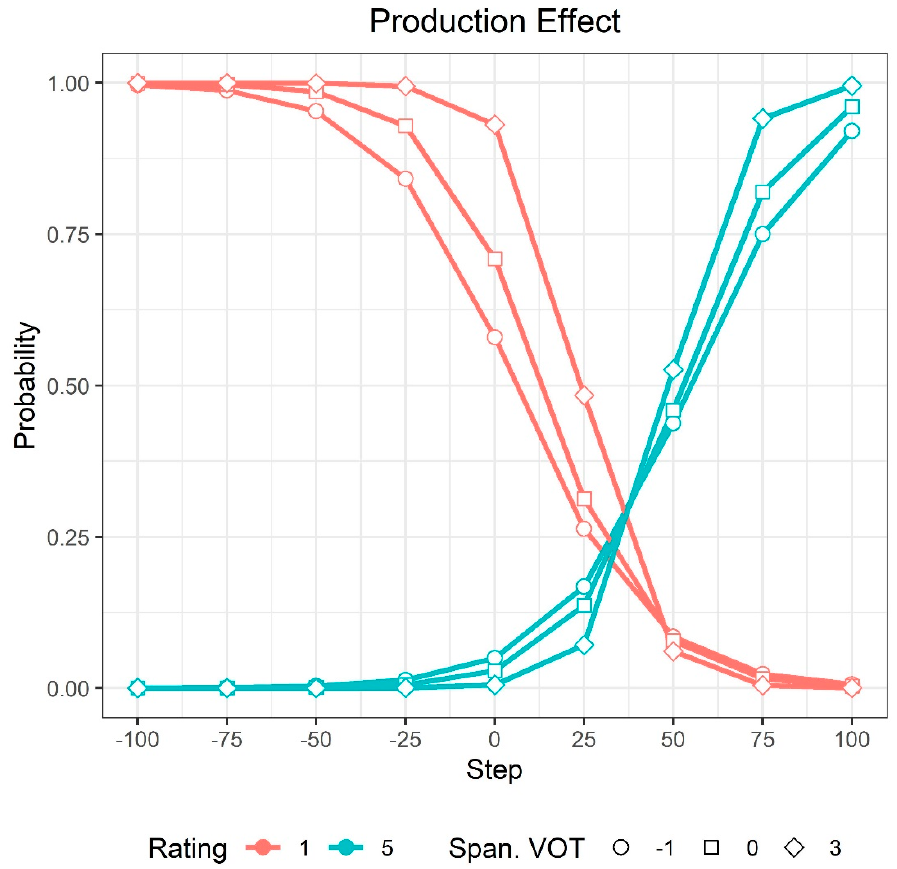
Figure 4. Predicted probabilities of response ratings for voiceless trials as a function of participants’ model-estimated VOT production in Spanish. Spanish VOT production was standardized, such that 0 = the group average, − 1 to a participant 1 SD below the mean, and +3 to a participant 3 SD above the mean, where − 1 and +3 SD represent the two extremes of the Spanish VOT production continuum in this participant sample. To avoid visual clutter, and because participants tended to choose ratings 1 and 5 much more frequently than the other rating options, only those two probability functions are plotted. On the 5-point scale, 1 = “bad” and 5 =